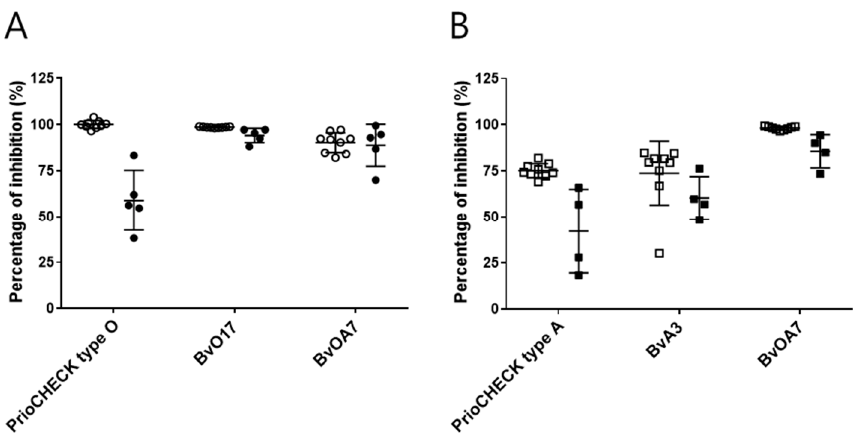
Figure 4. Detection of FMDV antibodies in the serum samples from vaccinated and virus-challenged animals using bovine scFv antibody-based SPCE. ( A ) For type O antibody detection in the serum samples from vaccinated cattle (n = 9, ○ ) and FMDV (O/Anseong/SKR/2002)-challenged pigs (n = 5, ● ), BvO17 and BvOA7-based SPCEs were carried out as described in Figure S3, and their perfor- mance was compared with a parallel experiment using PrioCHECK type O antibody ELISA Kit. The results were expressed as a percentage of inhibition as described in Materials and Methods. ( B ) For type A antibody detection in the serum samples from vaccinated cattle (n = 9, □ ) and FMDV (A/Yeoncheon/SKR/2017)-challenged pigs (n = 4, ■ ), BvA3 and BvOA7-based SPCEs were carried